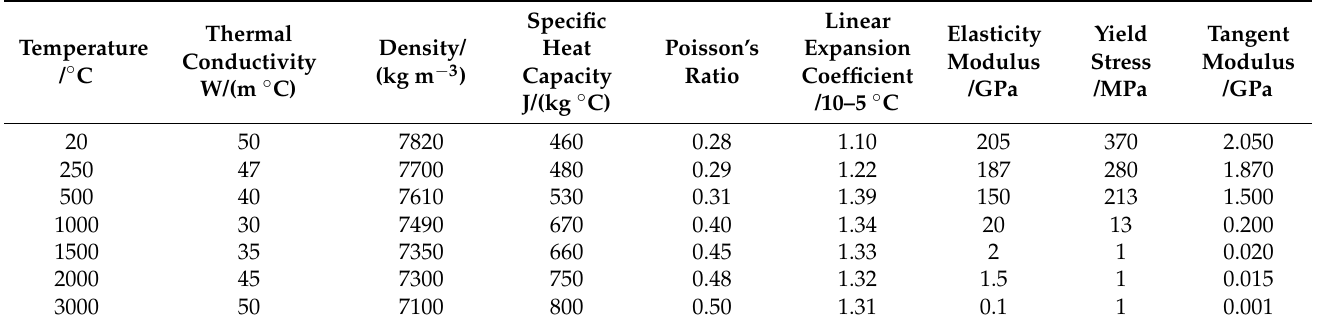
Table 1. Temperature-dependent thermal and mechanical properties of Q345 steel.